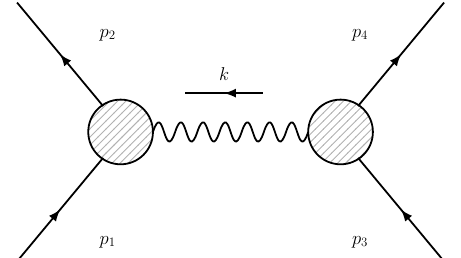
Figure 2. Tree-level singularity for one-graviton